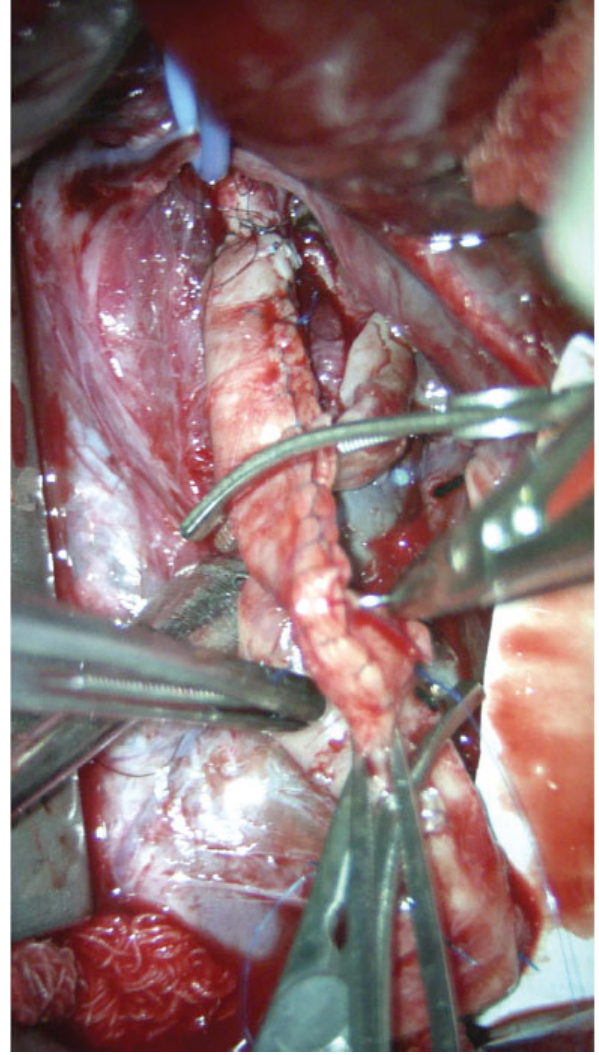
Fig. 2 Intraoperative photograph taken using the microscope with the patient ’ s head located toward the top of the image. The photo- graph shows the cadaveric graft, which was tapered ex vivo using a running suture of 7 – 0 polypropylene, as well as the proximal anas- tomosis, which was performed using interrupted 8 – 0 nylon to the stenotic native aorta. The blue vessel loop is around the inferior mesenteric artery.